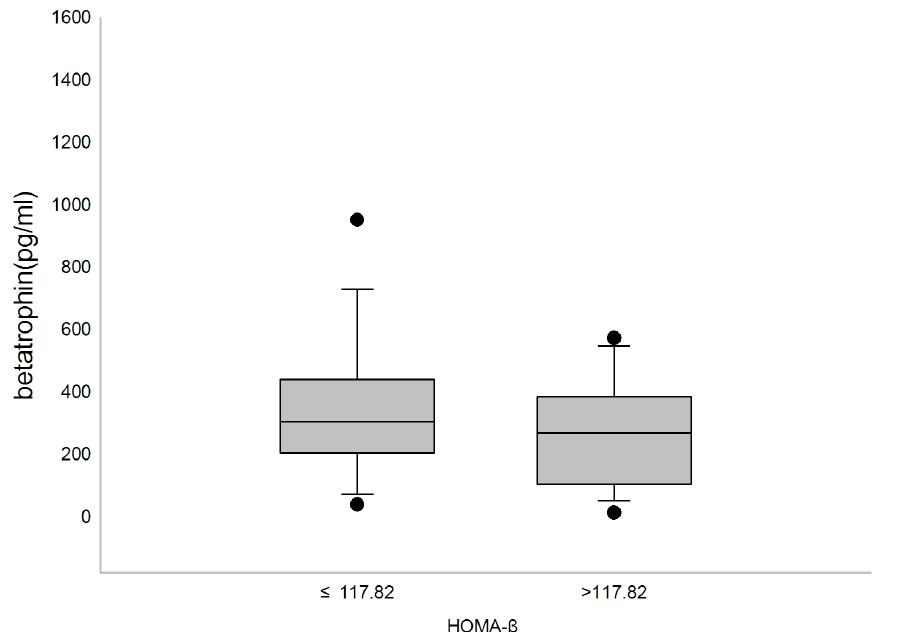
Fig 2. Serum betatrophin levels of subjects with different levels of beta cell function. Box plot for serum betatrophin levels in subjects with HOMA- β below or equal to 117.82 (Q3) and subjects with HOMA- β above 117.82. Serum betatrophin levels were significantly different between the two groups ( P < 0.05).